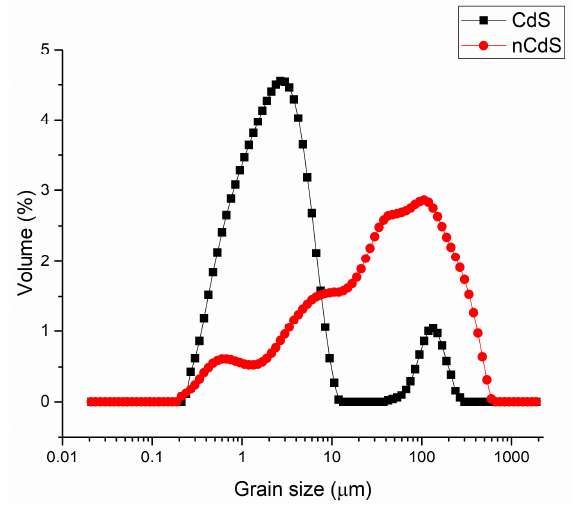
Figure 9. Grain size distribution of aCdS and cCdS samples.